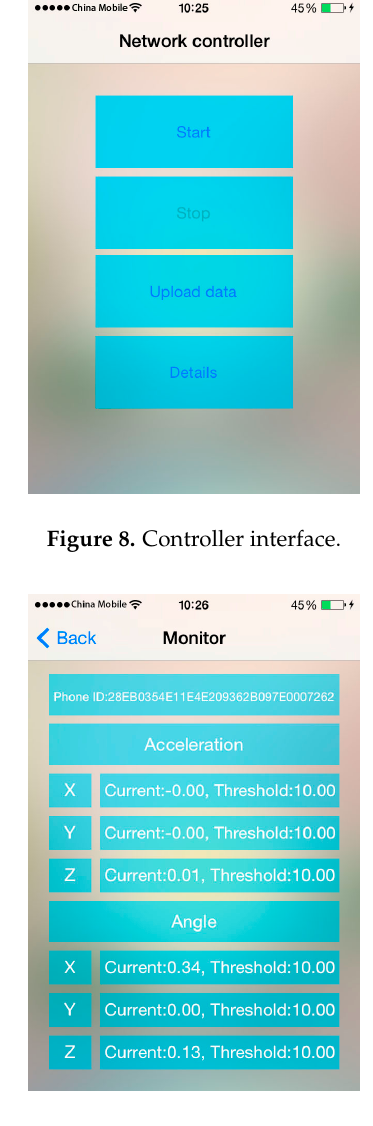
Figure 9. Interface of the real-time monitoring system.